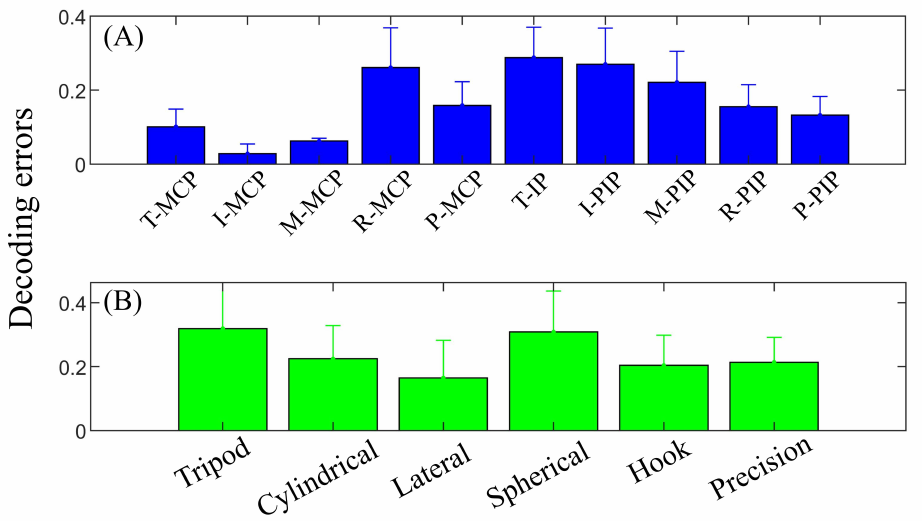
Figure 8. Decoding error based on ten joints ( A ) and six grasp types ( B ). MCP joints of the thumb, index and middle have lower errors than respective IP/PIP joints, whereas MCP joints of the ring and pinky have relatively higher